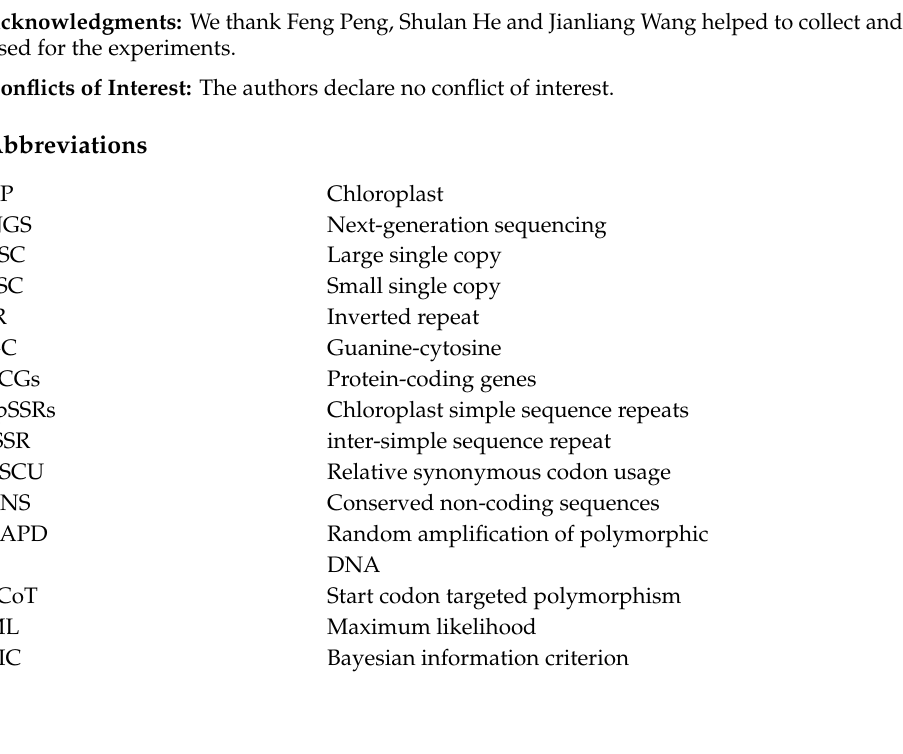
Table S1: Splitting genes with introns and exons in the chloroplast genomes of seven Lycoris species, Table S2: Chloroplast simple sequence repeats (cpSSRs) of seven Lycoris species, Table S3: Relative synonymous codon usage (RSCU) in the Lycoris chloroplast genomes, Table S4: The GenBank accession numbers of complete chloroplast genome sequences used for phylogenetic